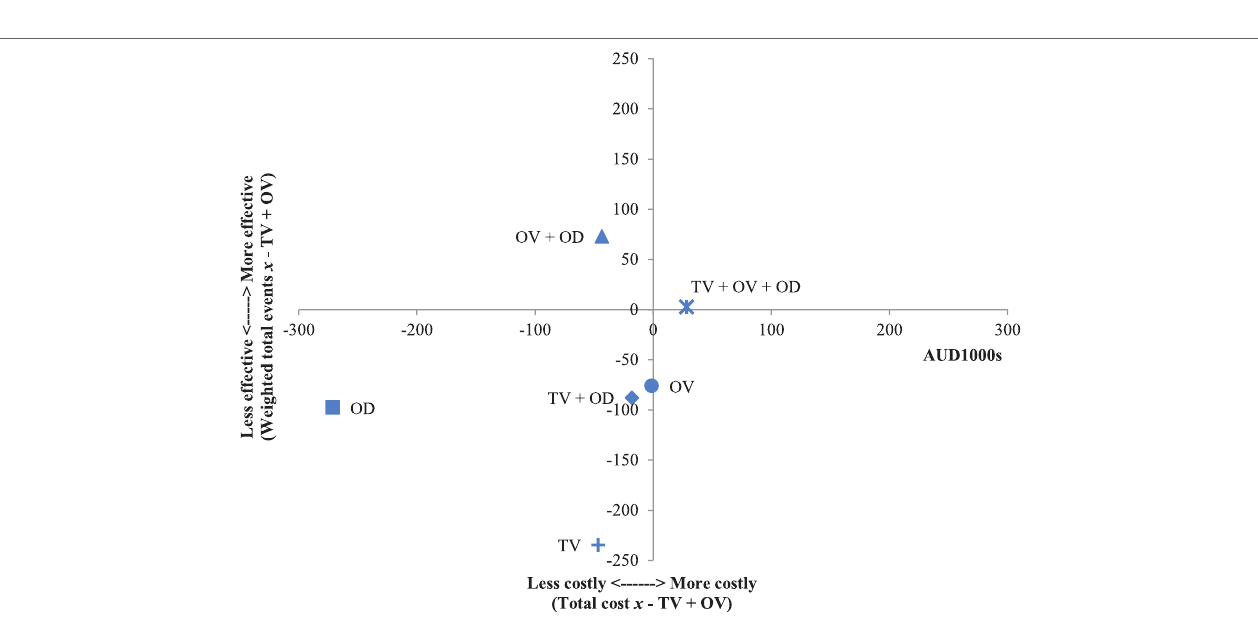
FiguRE 4 | Incremental cost-effectiveness of each format compared with television (TV) + online video (OV). The cost-effectiveness of TV + OV forms the baseline (cross-section of x and y axes). Effectiveness is weighted total events of each format ( x ) compared with TV + OV. Cost is total costs in AUD1,000s of each format ( x ) compared with TV + OV. Data points that fall in the upper left quadrant represent formats that are more cost-effective than TV + OV.